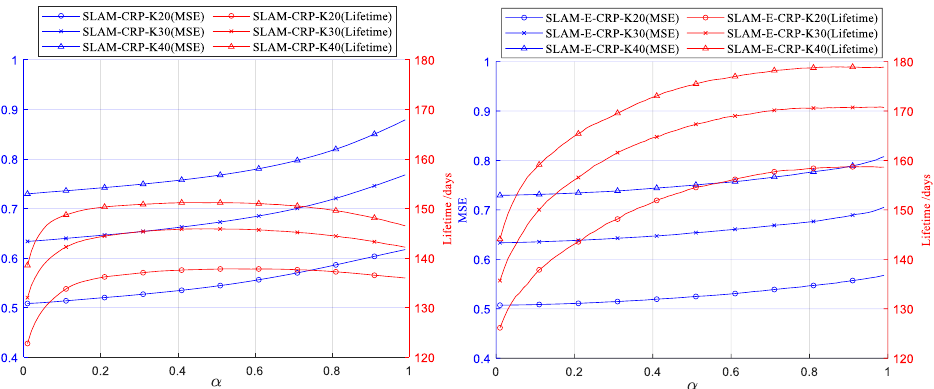
Figure 7. Variation of network lifetime and MSE with respect to 𝛼 in Equation (10) (SLAM and SLAM-E).